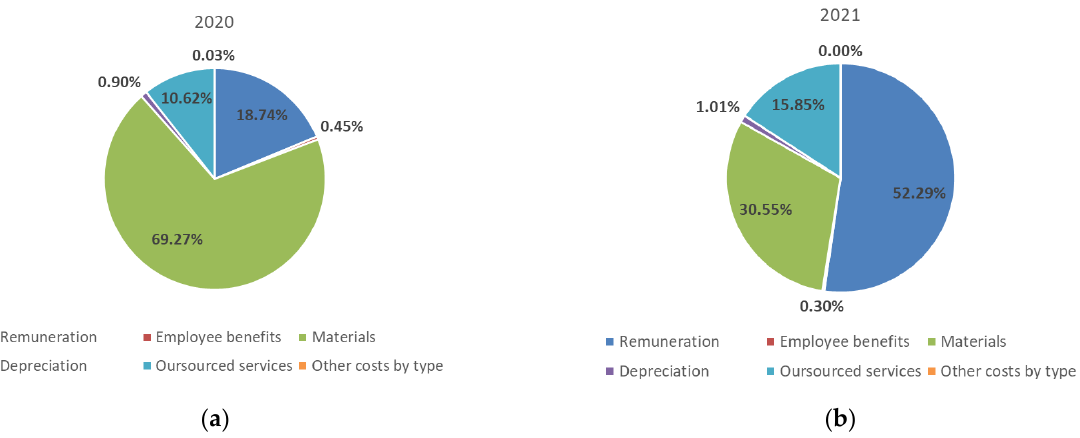
Figure 13. Percentage of individual generic costs incurred for the COVID-19 pandemic in 2020 ( a ) and 2021 ( b ).